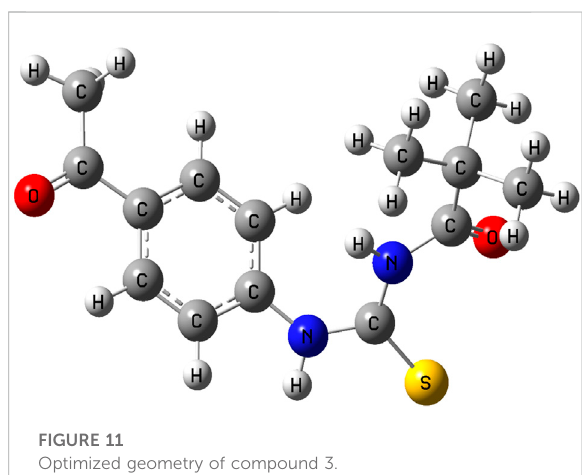
FIGURE 9 The 3D representations of Hirshfeld surface with the function d norm . (A) H (cid:129)(cid:129)(cid:129) O/O H interactions.